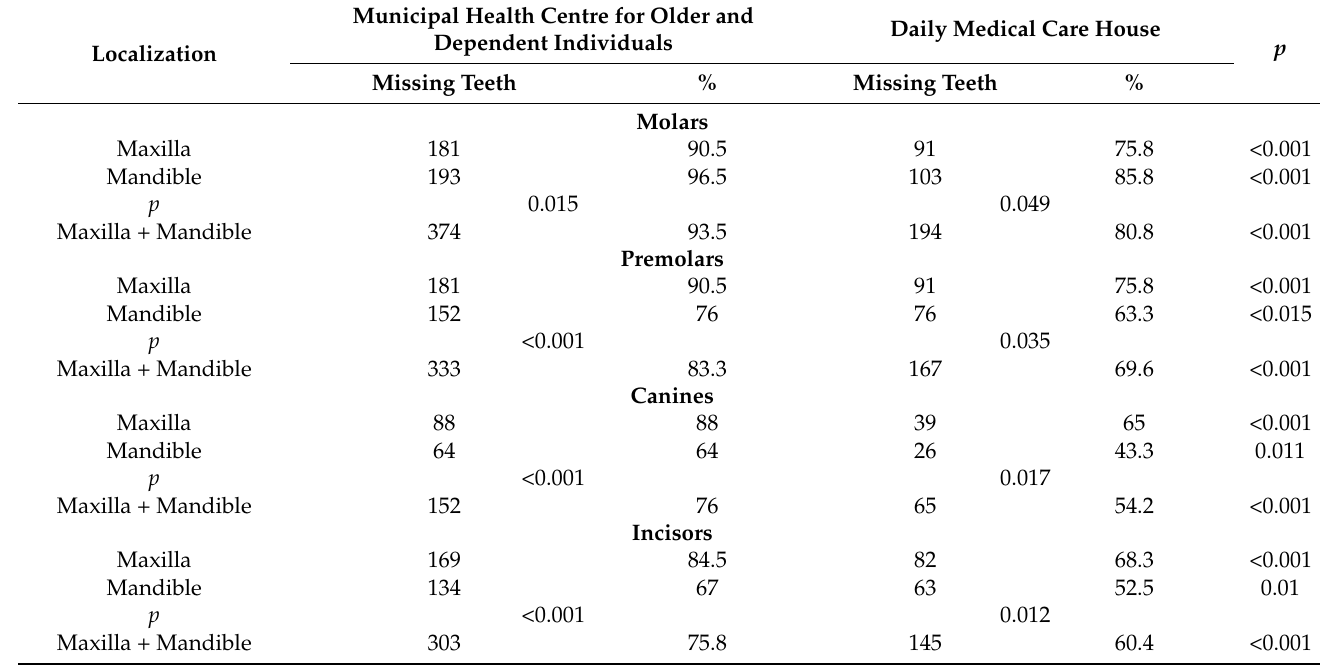
Table 3. Distribution of missing teeth in the study